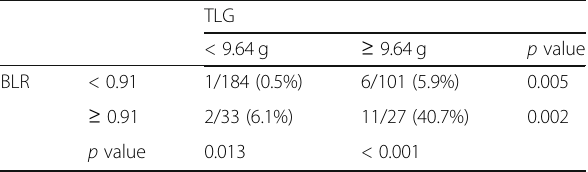
Table 5 Distant recurrence rate according to the combination of TLG and